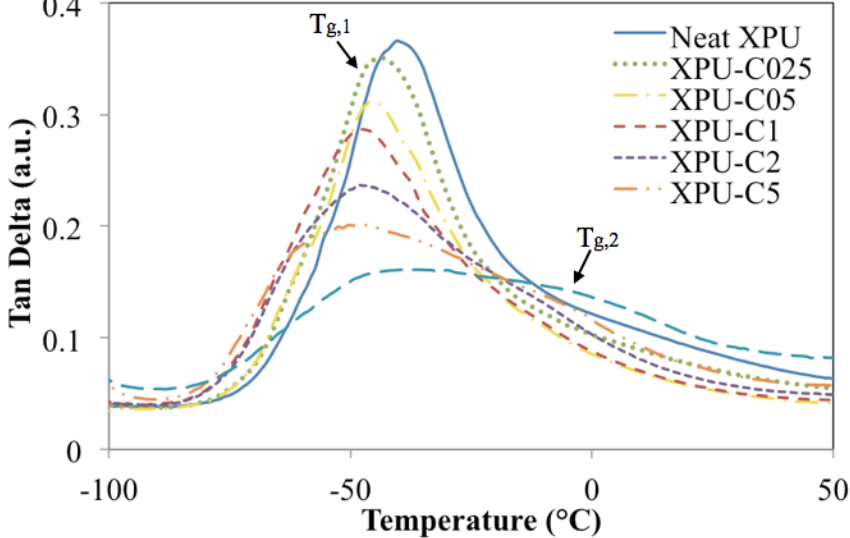
Figure 9. The variation of tan δ peak height with temperature and composition. Blue dashed line—XPU-C10.